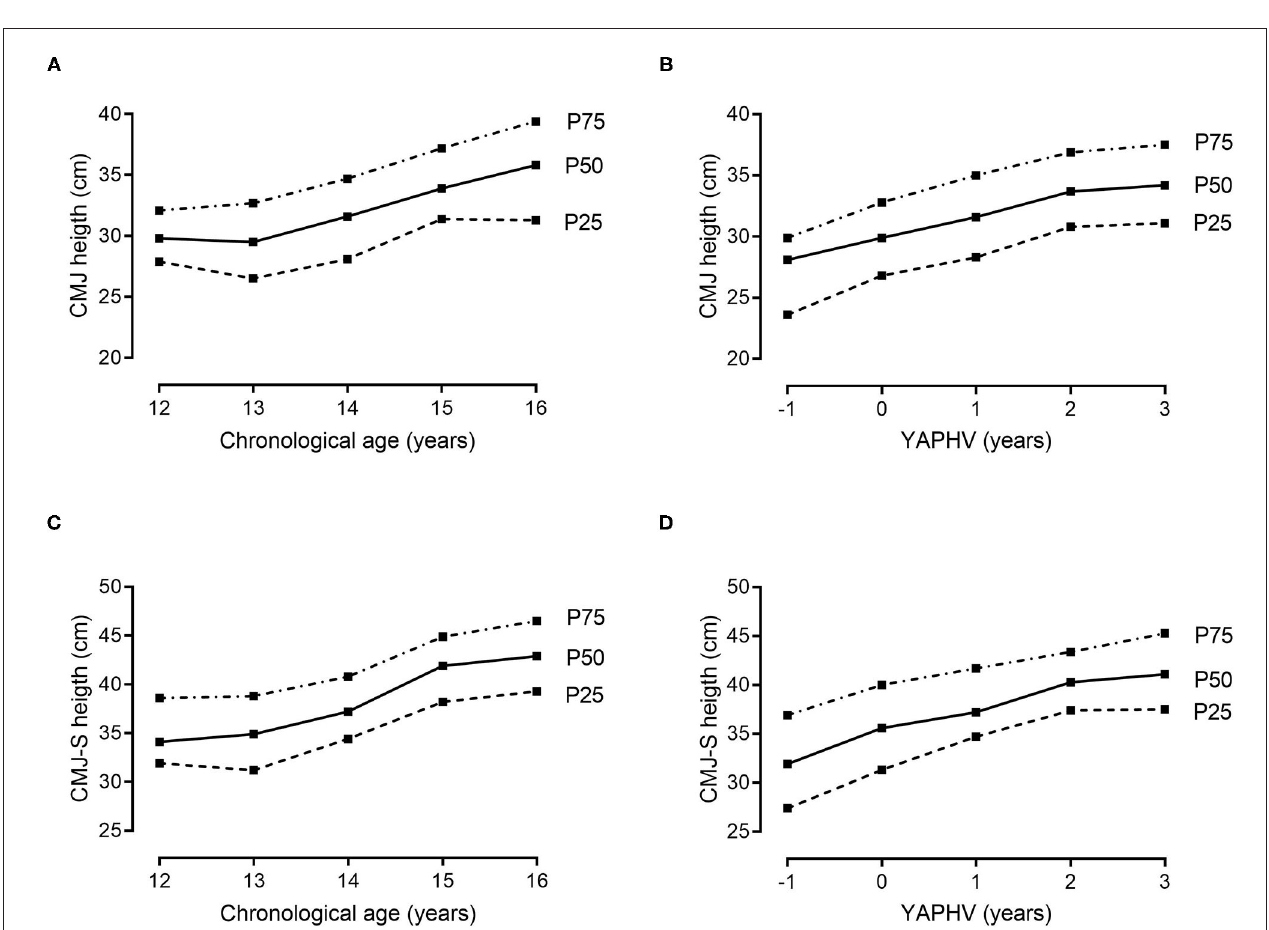
FIGURE 1 | References values (10th, 25th, 50th, 75th and 90th percentiles) for body mass, stature and arm span of young Portuguese male basketball players, according to their chronological age and maturity status.